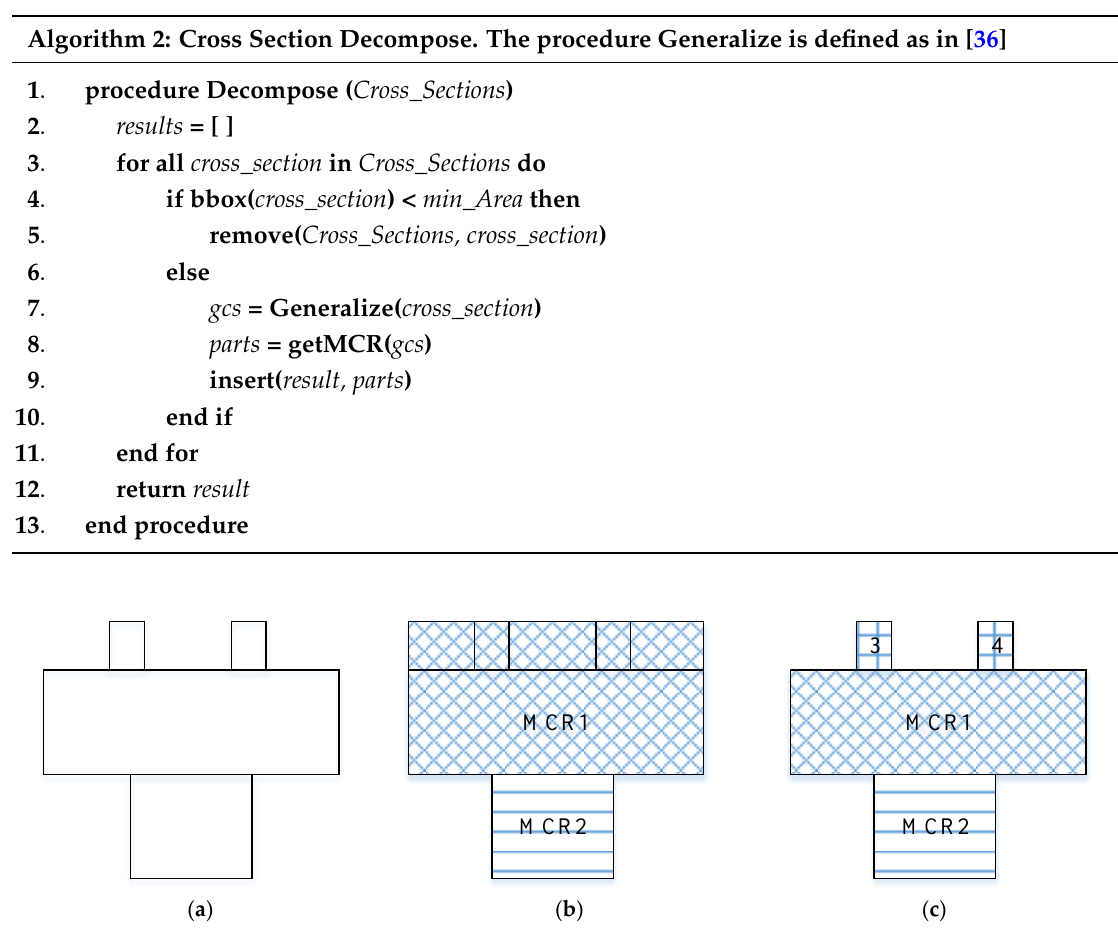
Algorithm 4 ： Prototype Extraction 1.